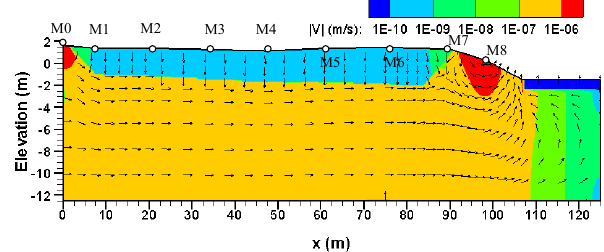
Fig. 8. Average Darcy velocity (banded colorful contours) in the mangrove transect calculated over the observation period of 3 days. Vectors with uniform length were used to indicate the velocity direction only.